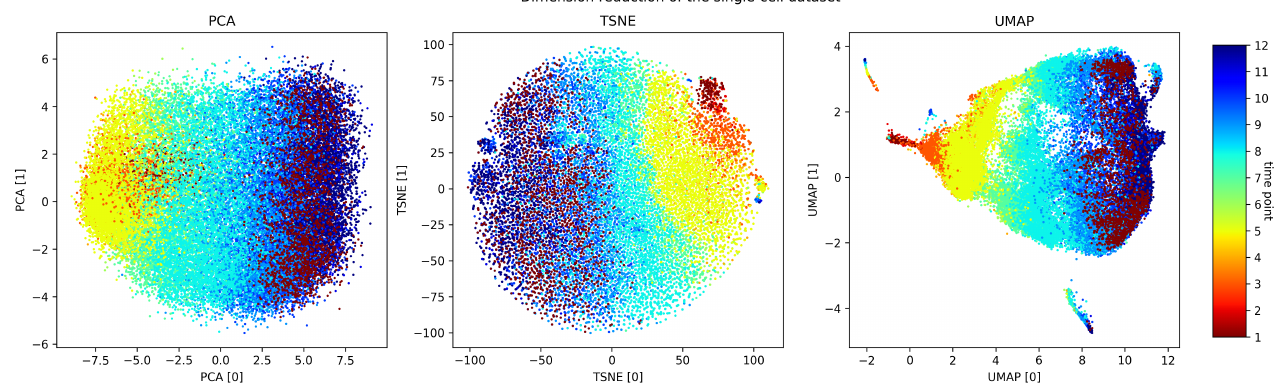
Figure 5. Dimension reduction of the dataset. PCA, TSNE, and UMAP applied to our preprocessed gene expression